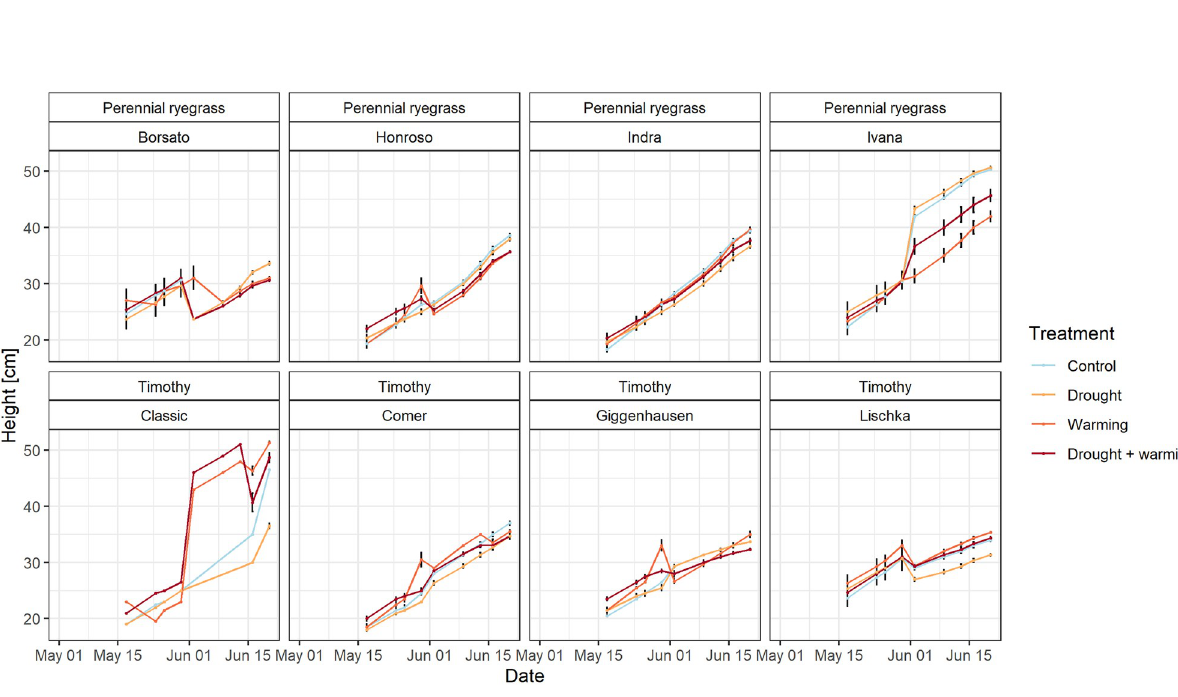
PLOS ONE | https://doi.org/10.1371/journal.pone.0248759 March 26,